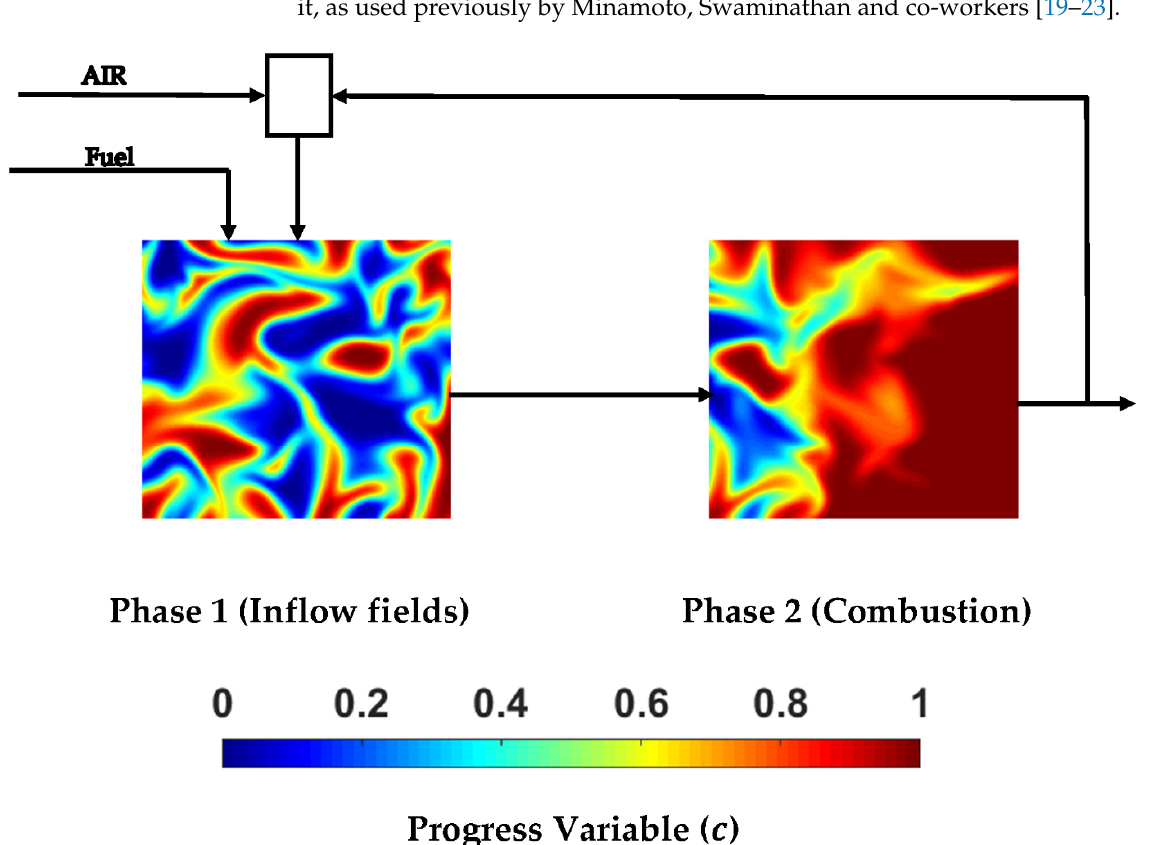
Figure 1. Schematic illustration of the two stages in the MILD combustion simulation. The species mass fractions, temperature and density for turbulent premixed flame simulations are initialised by the steady unstretched 1 D laminar premixed flame with φ = 0.8. A pseudo-spectral method [54] is used to initialise turbulent velocity fluctuations by a homogeneous isotropic field with prescribed values of u (cid:48) and l , according to Batchelor– Townsend spectrum